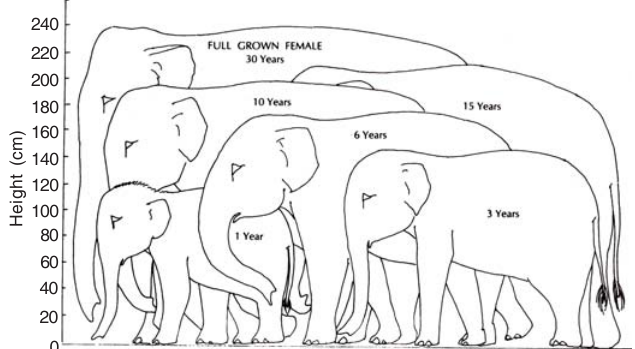
Figure 1. Relative height of young female elephants in relation to full grown female (after Sukumar